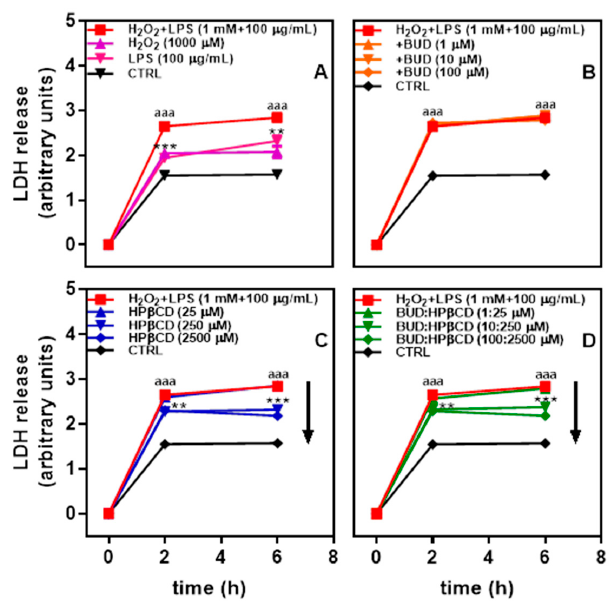
Figure 1. Lactate dehydrogenase (LDH) release after A549 cells incubation with H 2 O 2 , Lipopolysaccharides (LPSs), and H 2 O 2 + LPS for up to 6 h ( A ) and effect of budesonide (BUD) ( B ),